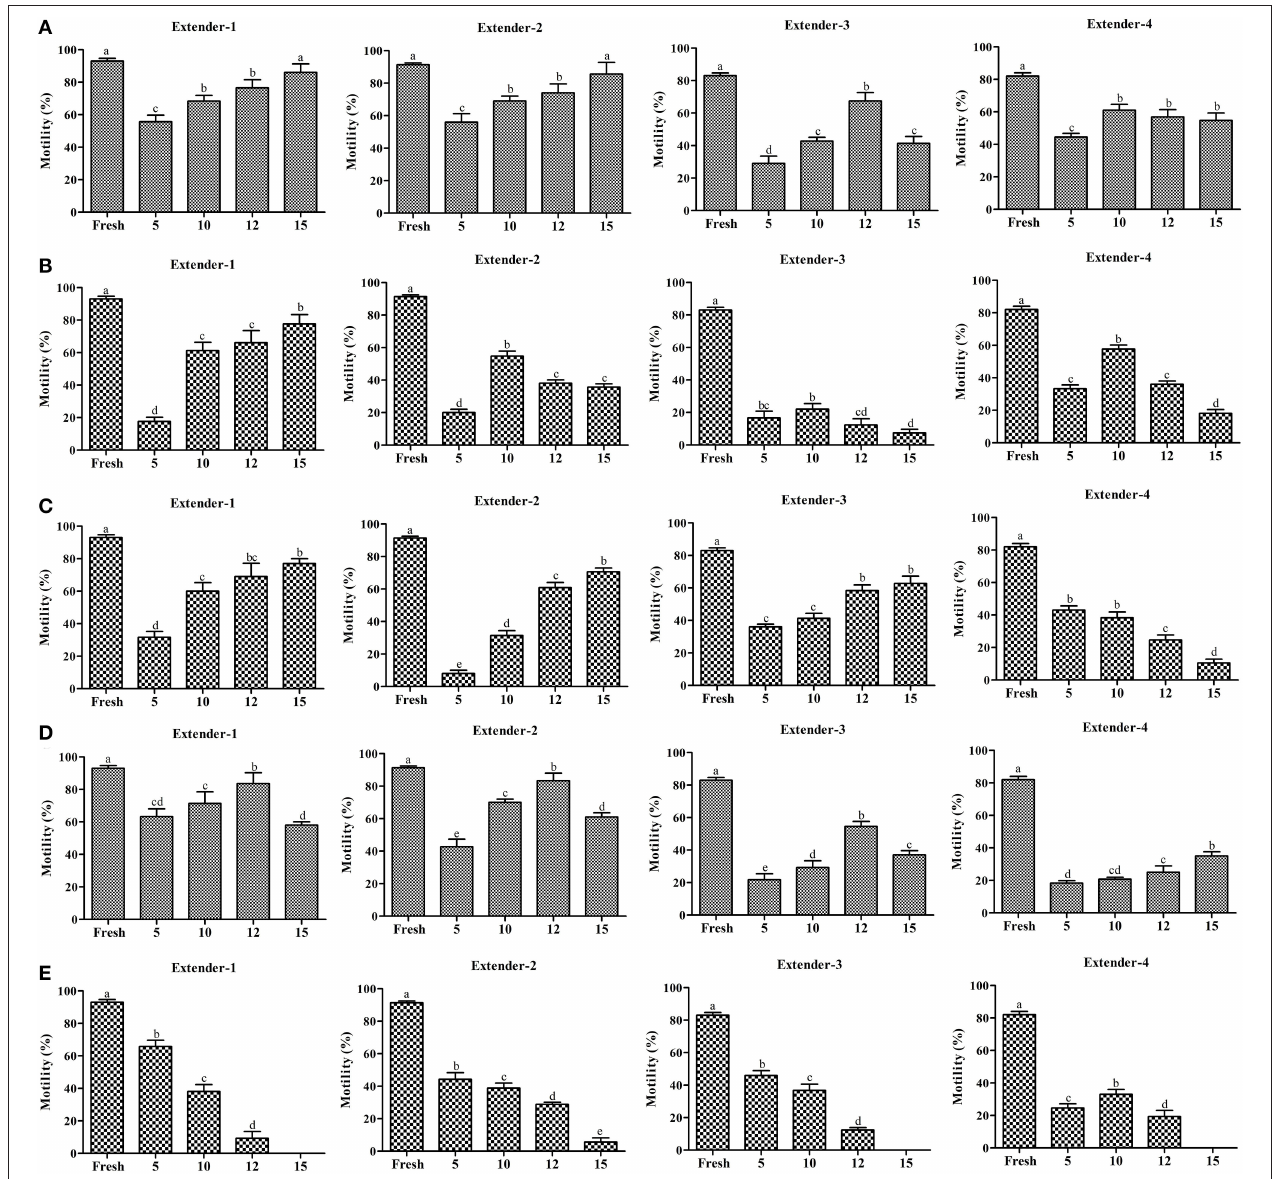
FIGURE 2 | Post-thaw motility ( n = 3) of sperm cryopreserved using different concentrations (5, 10, 12, and 15%) of cryoprotectants (Me 2 SO, EG, PG, GLY, and MeOH) combined with extenders (extenders-1, − 2, − 3, and − 4). (A) Post-thaw motility of sperm cryopreserved using different concentration of Me 2 SO combined with different extenders; (B) post-thaw motility of sperm cryopreserved using different concentration of EG combined with different extenders; (C) post-thaw motility of sperm cryopreserved using different concentration of PG combined with different extenders; (D) post-thaw motility of sperm cryopreserved using different concentration of GLY combined with different extenders; (E) post-thaw motility of sperm cryopreserved using different concentration of MeOH combined with different extenders. Significant different levels ( p < 0.05) are denoted by different